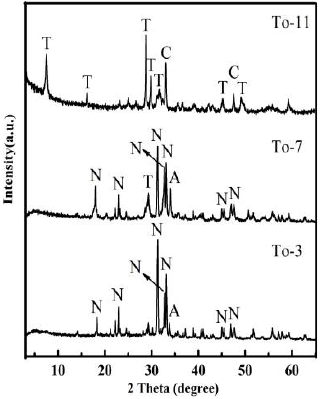
Figure 2. XRD pattern of products synthesized at different Ca/Si molar ratio at 160 °C for 12 h. N— NaCaHSiO 4.